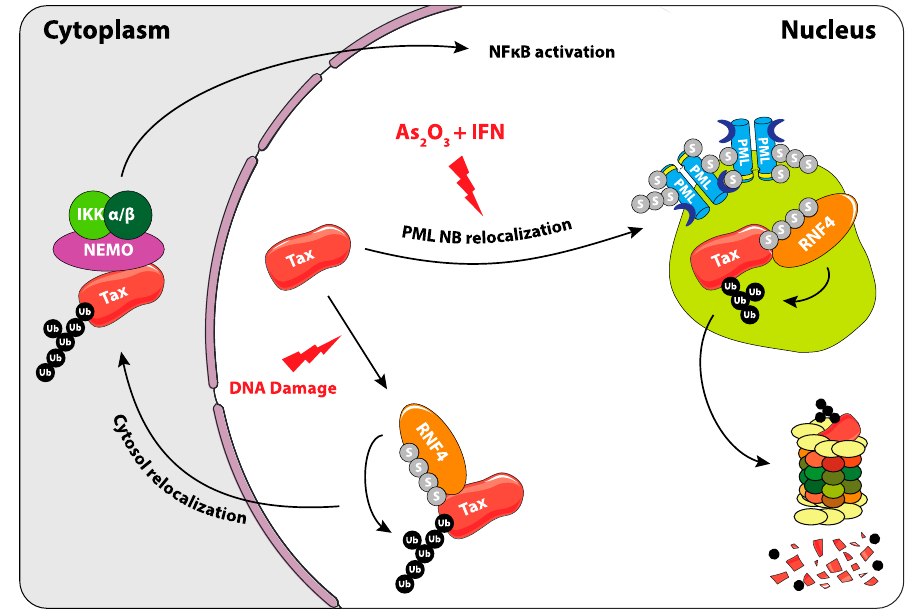
Figure 5. Role of SUMOylation in the regulation of Tax oncoprotein of the human T-cell lymphotropic virus type I (HTLV1) virus. Upon As 2 O 3 and INF α treatment, Tax is recruited to PML NBs. It is then poly-SUMOylated, recognized by RNF4, poly-ubiquitylated, and degraded by the proteasome. Another involvement of SUMOylation in the regulation of Tax was shown upon DNA damage, where its RNF4-dependant ubiquitylation triggers its cytosolic translocation. This leads to the activation of the NF κ B pathway, probably thanks to its ability to bind to and activate NEMO and the IKK